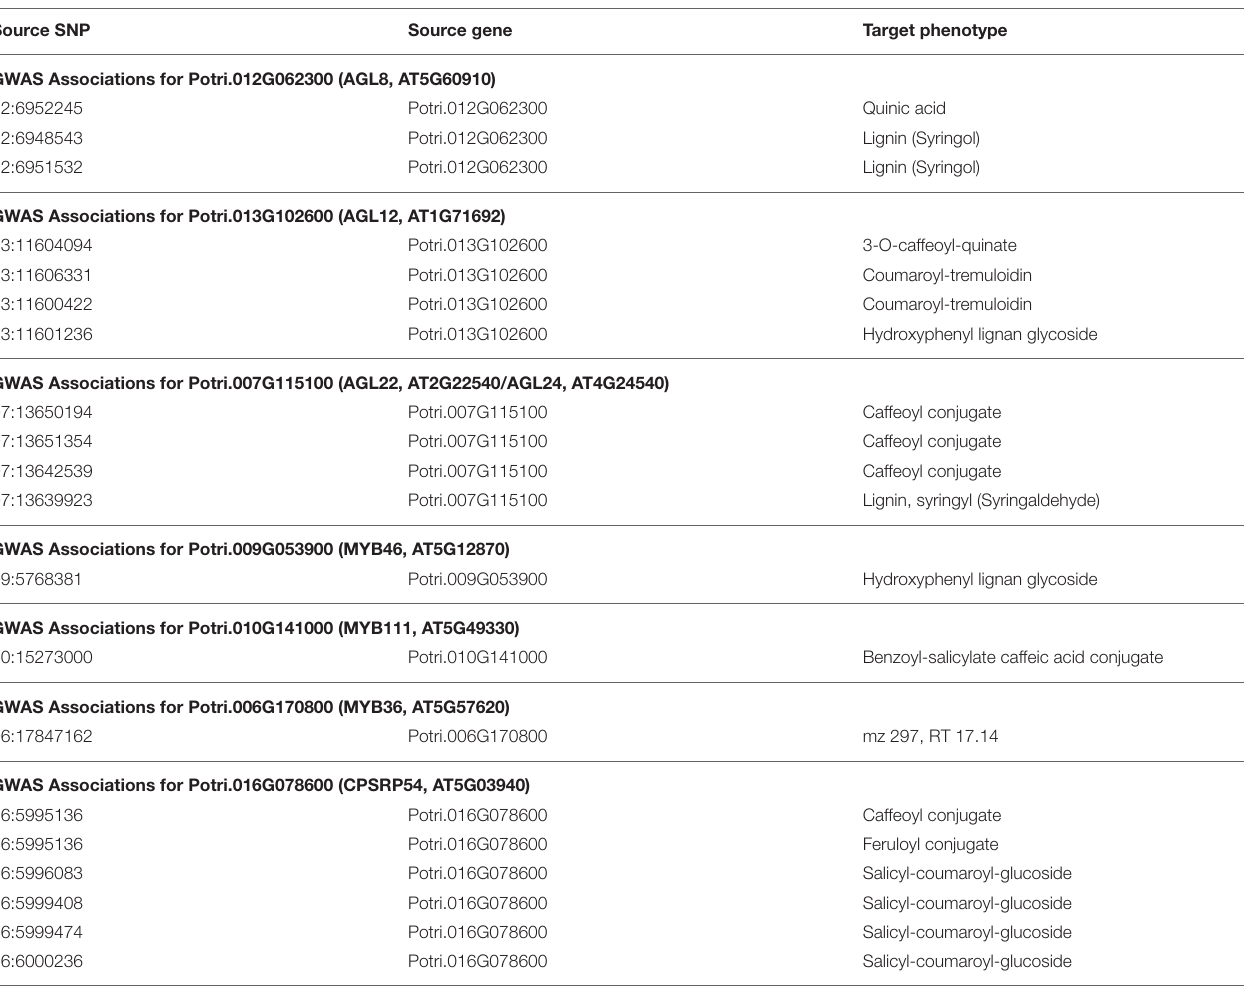
TABLE 1 | GWAS associations for select new potential target genes, indicating the SNP(s) within the potential new target gene which are associated with the lignin-related phenotype(s). Source SNP Source